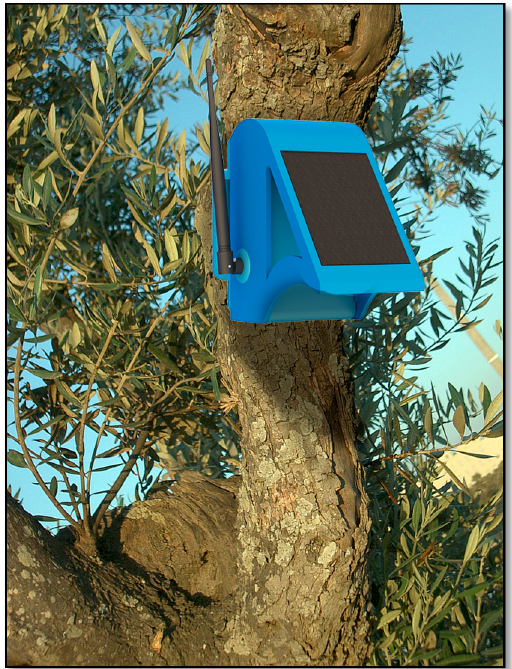
Figure 6. Placement of the monitoring device in an olive tree.